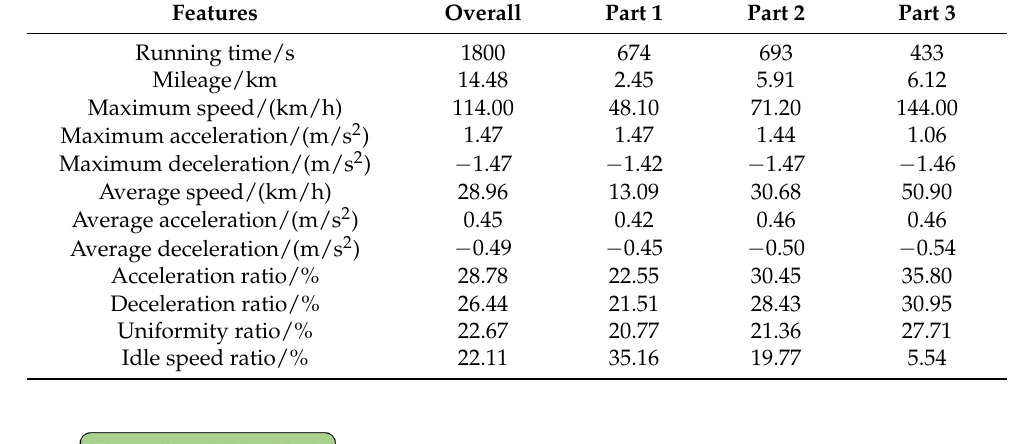
Table 2. The statistical characteristics of CLTC-P working conditions.